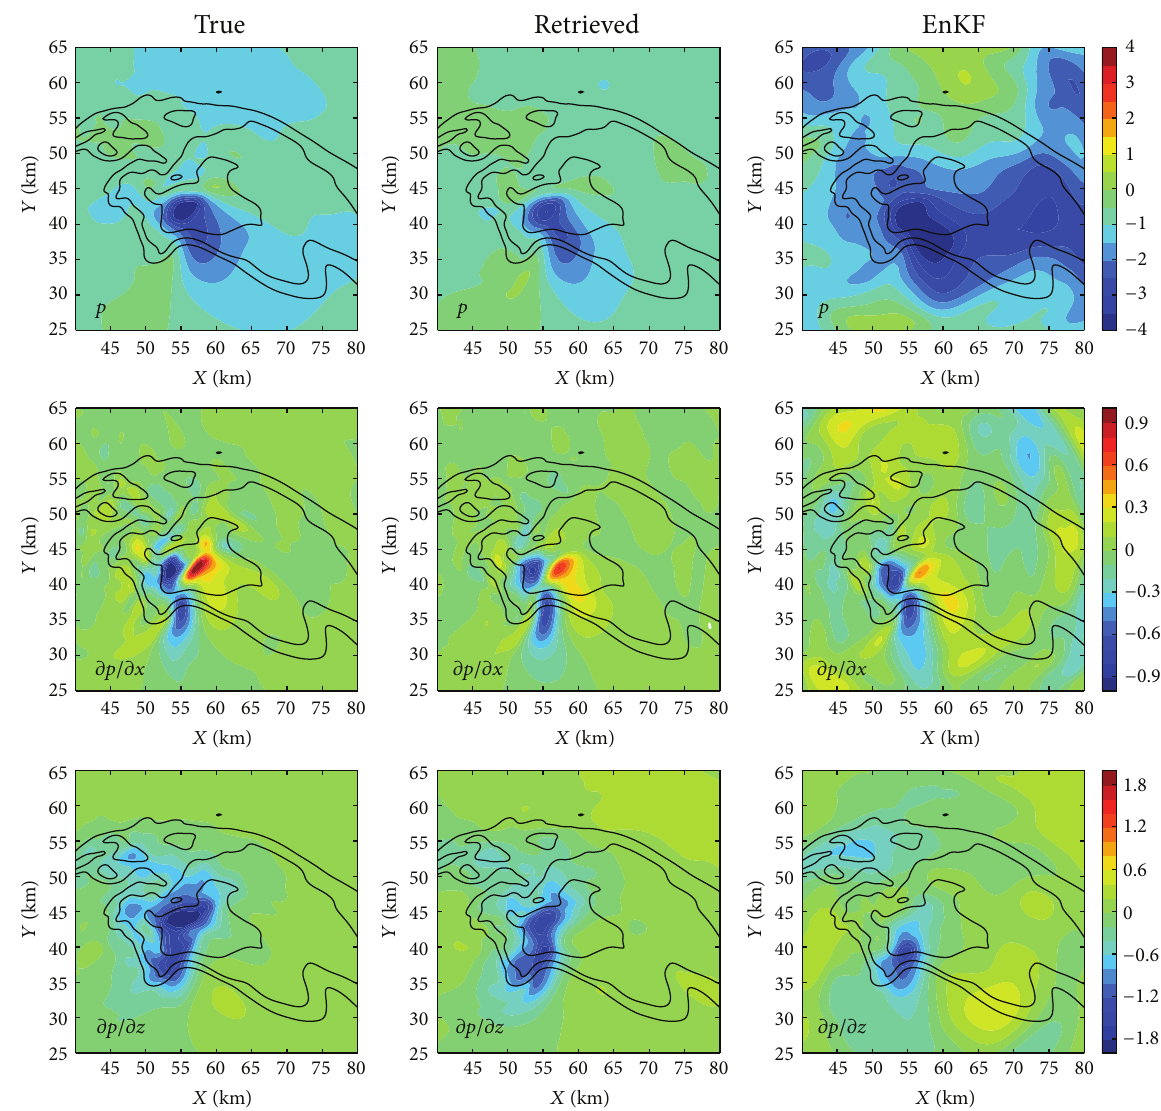
Figure 7: True (left column), retrieved (middle column), and EnKF mean posterior (right column) 𝑝 (top row), 𝜕𝑝/𝜕𝑥 (middle row; hPakm −1 ), and 𝜕𝑝/𝜕𝑧 (bottom row; hPa km −1 ) at 𝑧 = 0.9 km, 𝑡 = 50 min. The true 𝑝 were filtered and averaged as in Potvin et al. [23] to permit more direct comparisons with the (coarser) EnKF 𝑝 . Radar reflectivity factor is contoured at 10, 30, and